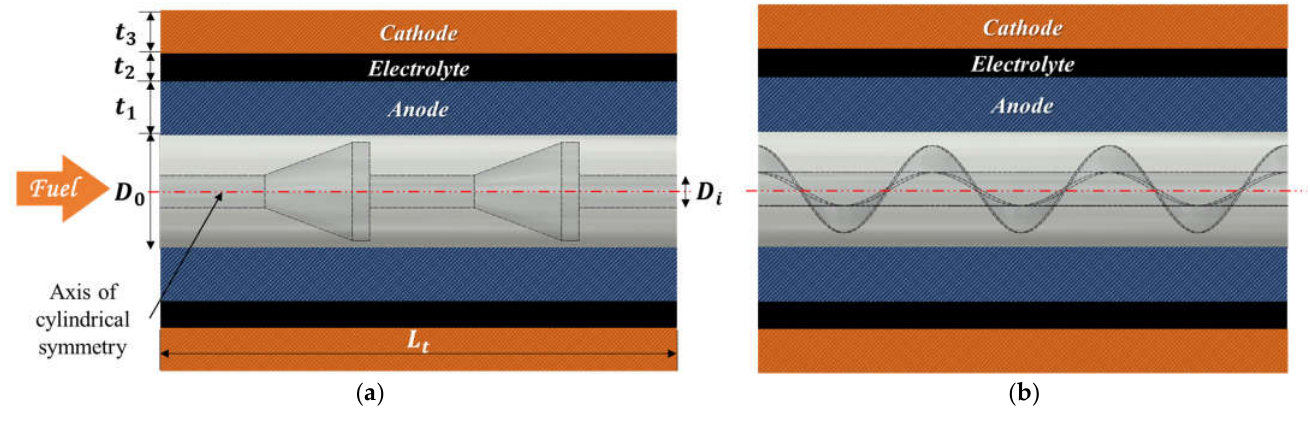
Figure 1. Schematic of micro-tubular solid oxide fuel cells with ( a ) cone-insert and ( b ) helical screw insert. Table 1. The geometry details of the micro-tubular solid oxide fuel cells investigated in this study.